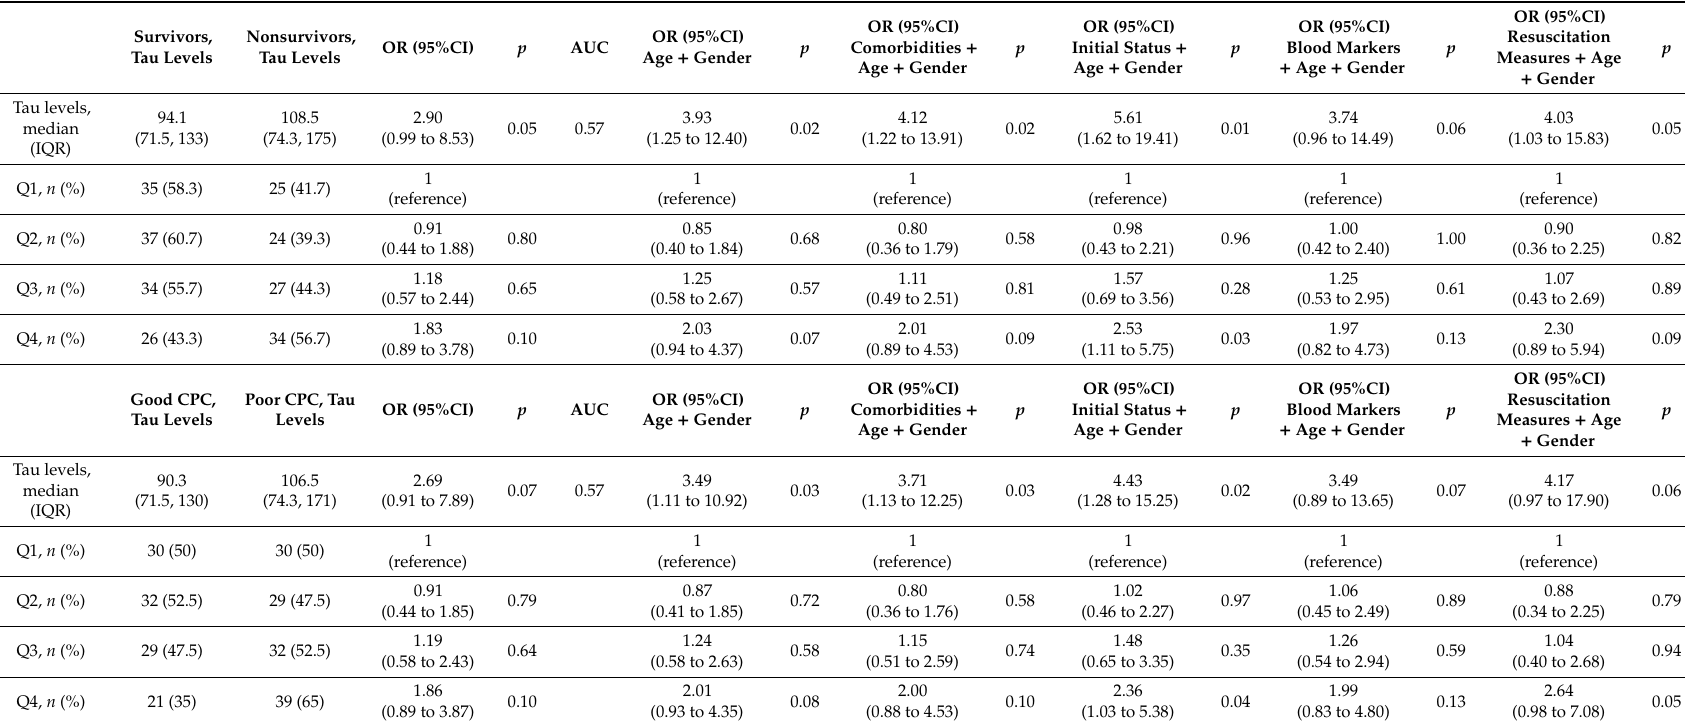
Table 3. Multivariable regression analysis for mortality and neurological